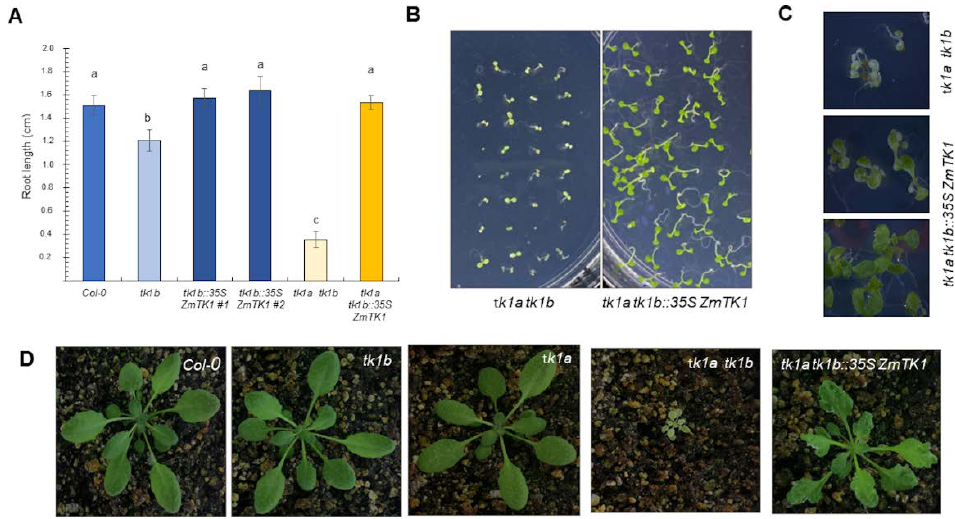
Figure 4. ZmTK1 complements Arabidopsis TK1 double mutants. ( A ) Root length of Col-0, Arabidopsis TK mutants and complemented mutants. Seedlings were germinated on Gamborg´s B5 (GB5) agar medium and root length was measured in 9-day seedlings; values are average ± standard deviation (SD, n = 20). Different letters indicate significant mean differences as analyzed by analysis of variance (ANOVA) followed by Tukey’s comparison test ( p < 0.01). Representative phenotypes of tk1a tk1b Arabidopsis mutants and complemented with ZmTK1 during seedling development ( B , C ) and in adult plants ( D ).